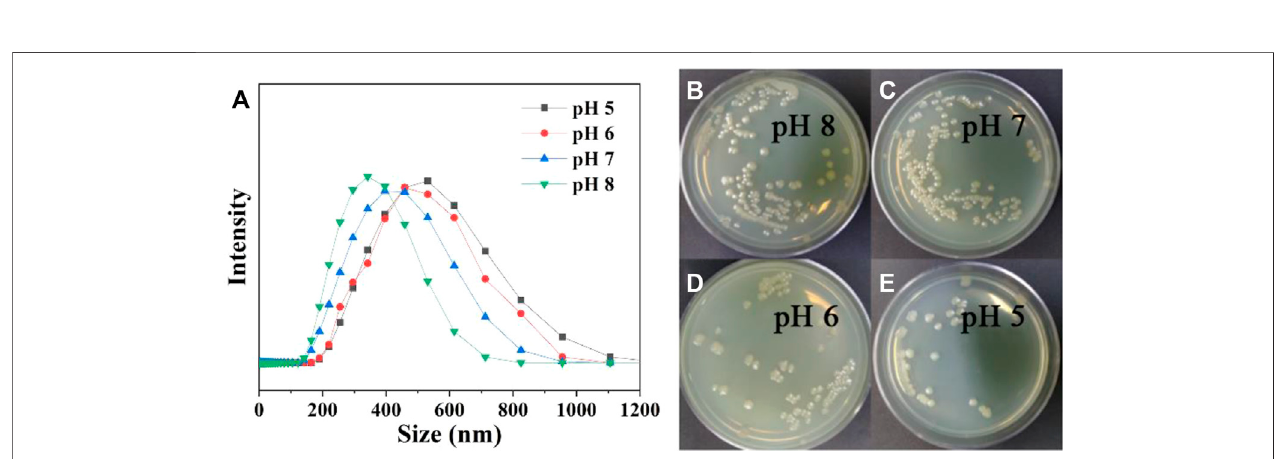
FIGURE 4 | Size of ALL@CS nanocapsules in different pH PBS solutions (A) . The plate colony images of ALL@CS incubating with E. coli for about 4 h (B – E) .